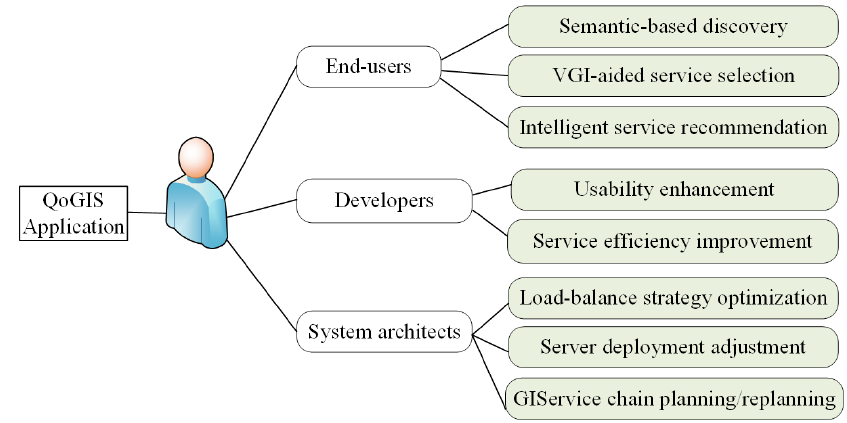
Figure 6. Typical application scenarios of QoGIS for different roles of users.